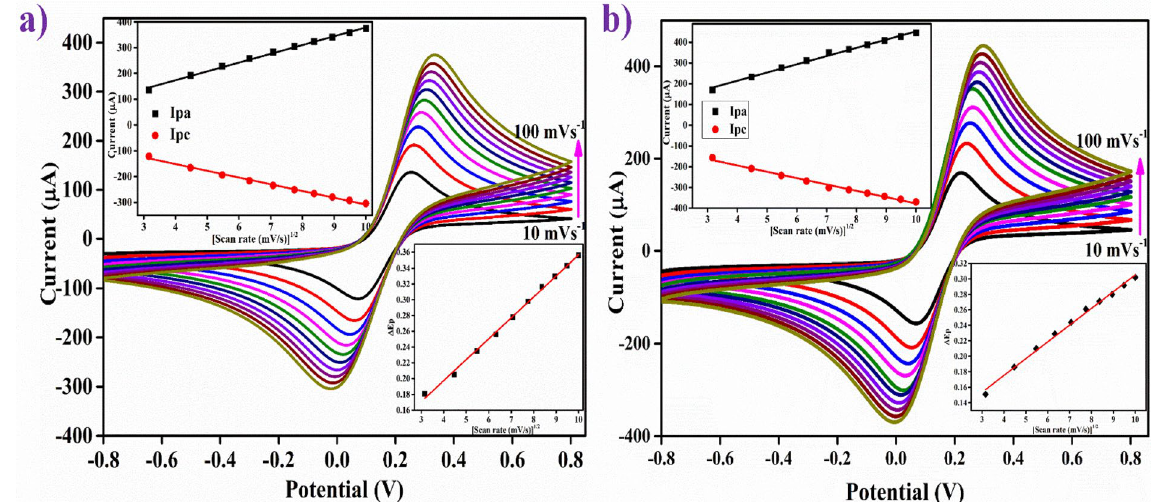
Figure 2. CV plots at different scan rates (10–100 mV/s) of ( a ) NIP/ITO and ( b ) MIP/ITO electrodes in pH 7.4 PBS containing 5 mM of [Fe(CN) 6 ] 3−/4− . Corresponding insets showed peak current (I pa and I pc ) vs. √ v (upper) and peak potentials (E pa and E pc ) vs. √ v (lower) for respective electrodes. Electrode m